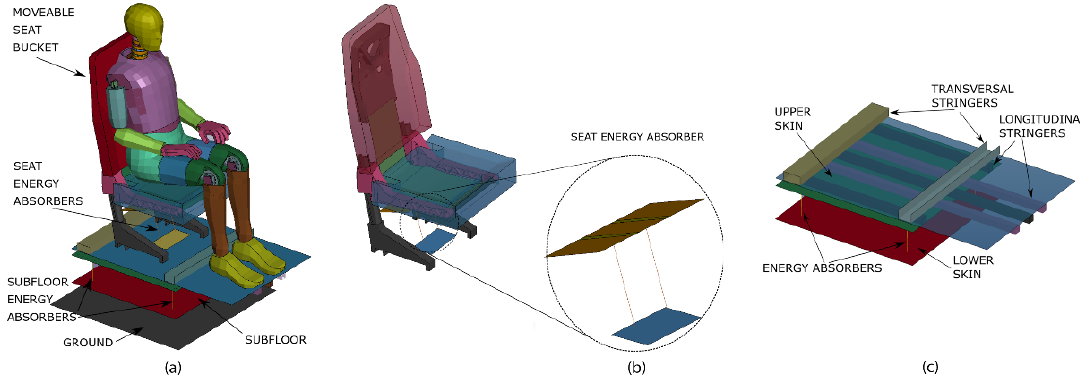
Figure 9. Finite element model: ( a ) full assembly with an ATD; ( b ) seat with energy absorber detail; ( c ) subfloor.